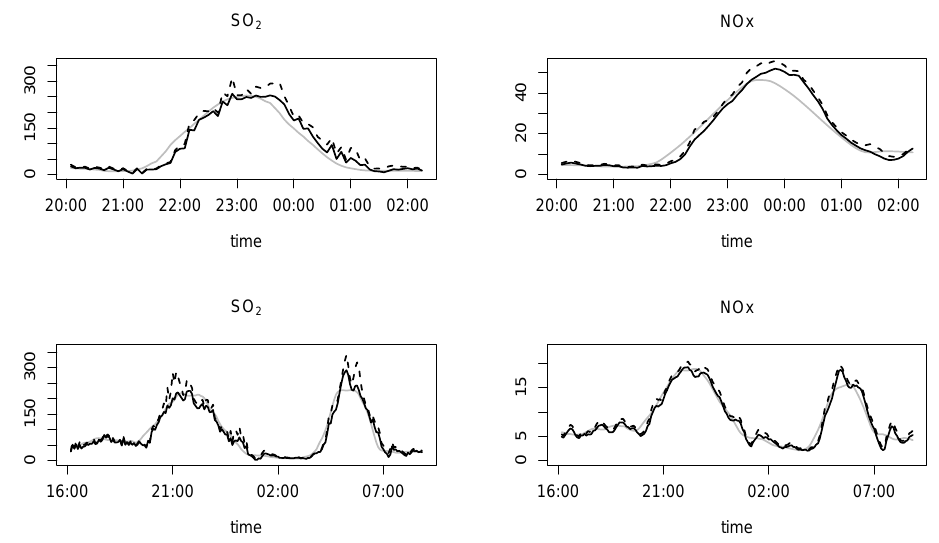
Figure 3. Observations (solid black line), mean (solid gray line) and 0.95 th quantile estimations (discontinuous line) for both pollutants, SO 2 and NO x and for two pollution